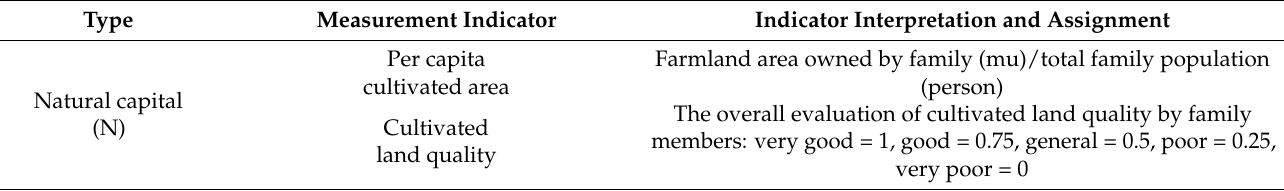
Table 1. Evaluation indicator system of resettled households’ livelihood